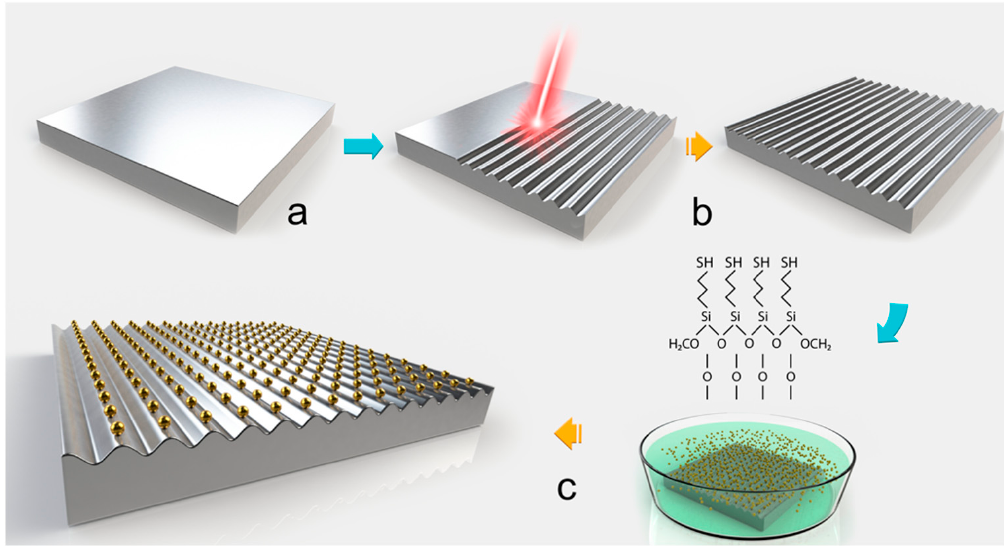
Figure 1. Schematic of the experimental process followed the fabrication of the Au nanoparticles (NPs)-based Si gratings. Flat Si substrate ( a ); nanopatterned by highly regular laser-induced periodic surface structure (HR-LIPSS) substrate of Si during ultrashort pulsed laser processing ( b ); functionalization procedure of nanopatterned Si surfaces and Au NPs immobilization procedure onto nanopatterned Si surfaces ( c ).